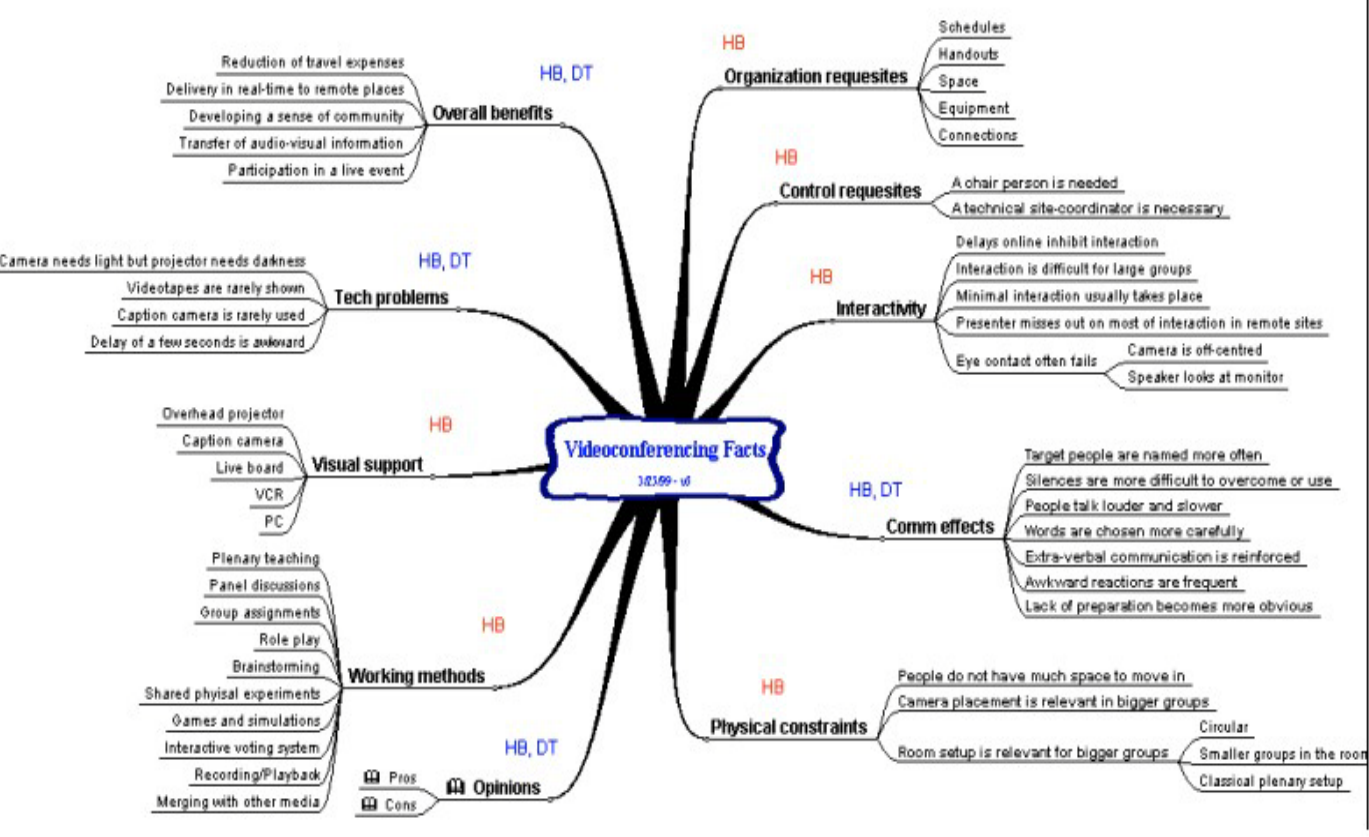
Figure 2. Structure of a knowledge map about “Videoconferencing Facts” developed with MindManager